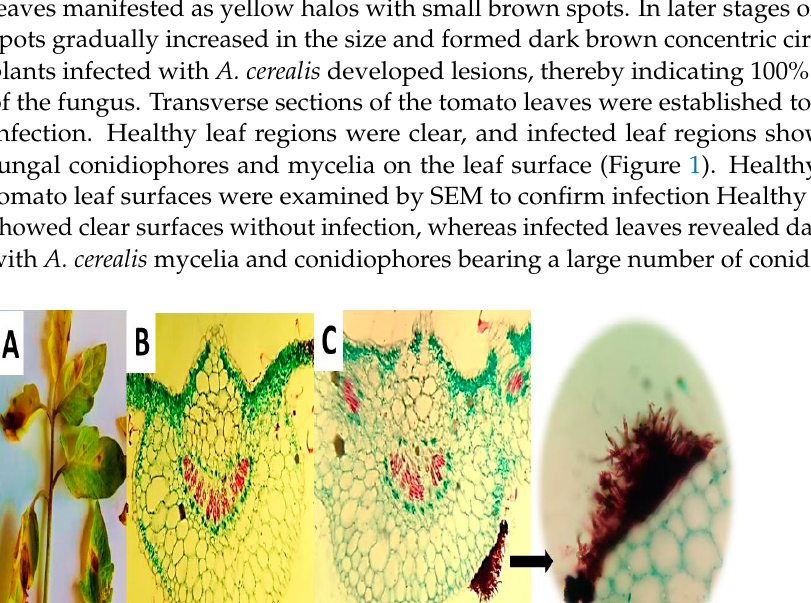
Figure 2. Scanning electron microscopy (SEM) of healthy and infected tomato leaf surfaces; healthy tomato leaf surface ( A ), A. cerealis (MT808477) conidiophores, mycelia and conidia on the surface of infected tomato leaf ( B , C ), and conidiophores bearing lots of A. cerealis conidia ( D ). 2.2. Morphological and Molecular Identification of Alternaria cerealis Alternaria cerealis (E.G. Simmons & C.F. Hill) AUMC 14484 was identified according to its morphological properties, including colony morphology, color, conidia, conidio- phore, and chlamydospore formation, under a light microscope. Colonies of A. cerealis show dark black mycelia surrounded by a white–gray mycelium in the initial stages of growth. The colonies then turned dark brown in later development stages (Figure 3A). Microscopically, the fungal isolate revealed chains of multicellular smooth-walled pale brown catenulate conidia with short beaks, secondary conidiophores of approximately 50 µm bearing secondary conidia (20–30 µm × 10–12 µm), and pale brown conidiophores